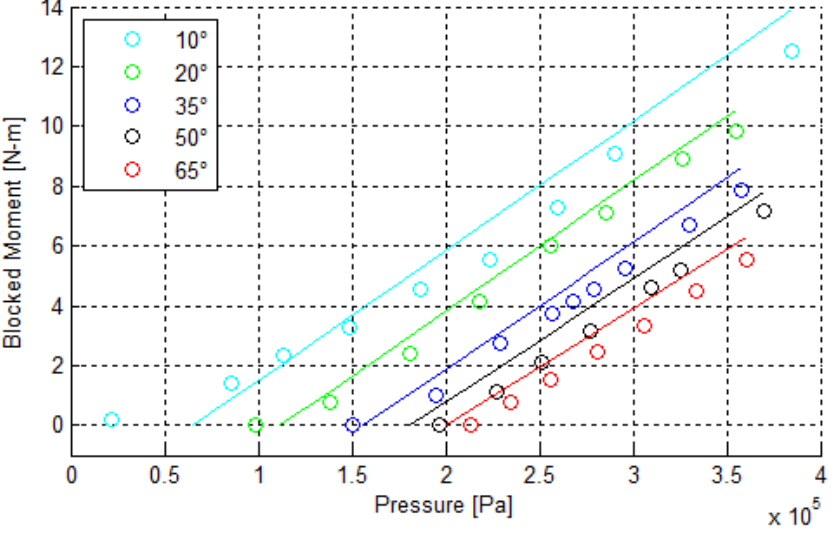
Figure 10. Blocked moment versus pressure, for prototype 3 of the HELM at different angles. Circles present experimental measurements, while lines present theoretical results.